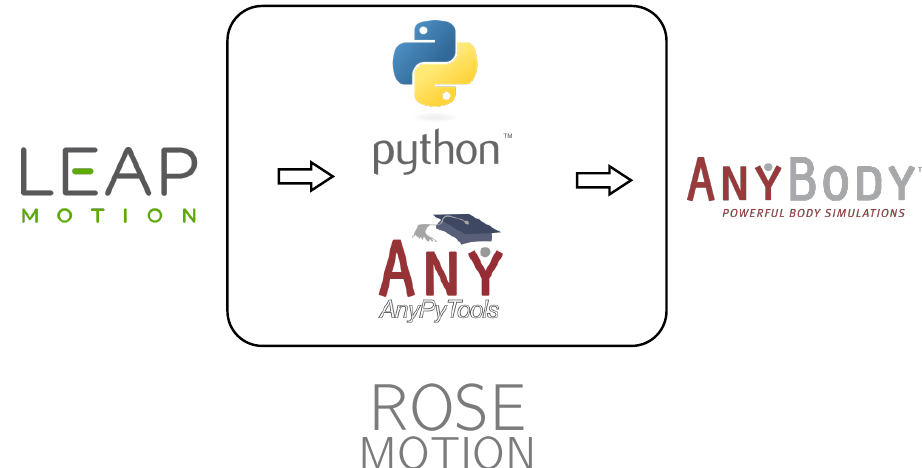
Figure 10. The program ROSE Motion provides an automated interface. The hand movement is recorded with the LMC. With the help of Python and the library AnyPyTools, the movement is transferred to the AMS, which can then be analyzed (source: Leap Motion logo [28], Python logo [33], AnyPyTools logo [30], and AnyBody logo